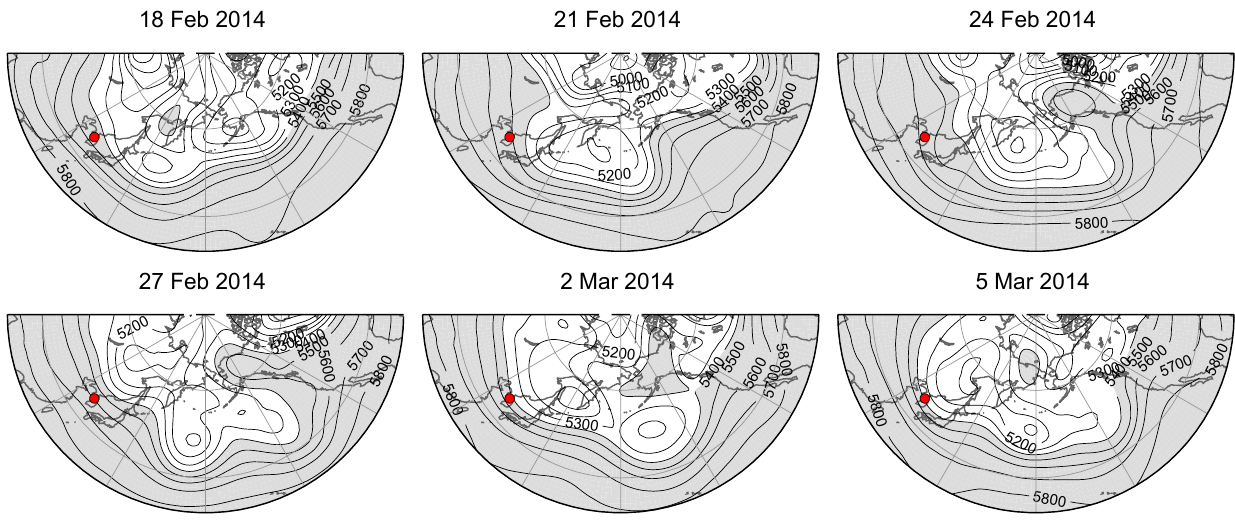
Figure 9. ERA-Interim daily mean geopotential height (contours; unit of gpm) at 500hPa. Seoul is marked with a solid red circle, and the areas for which the geopotential height is higher than 5400gpm are